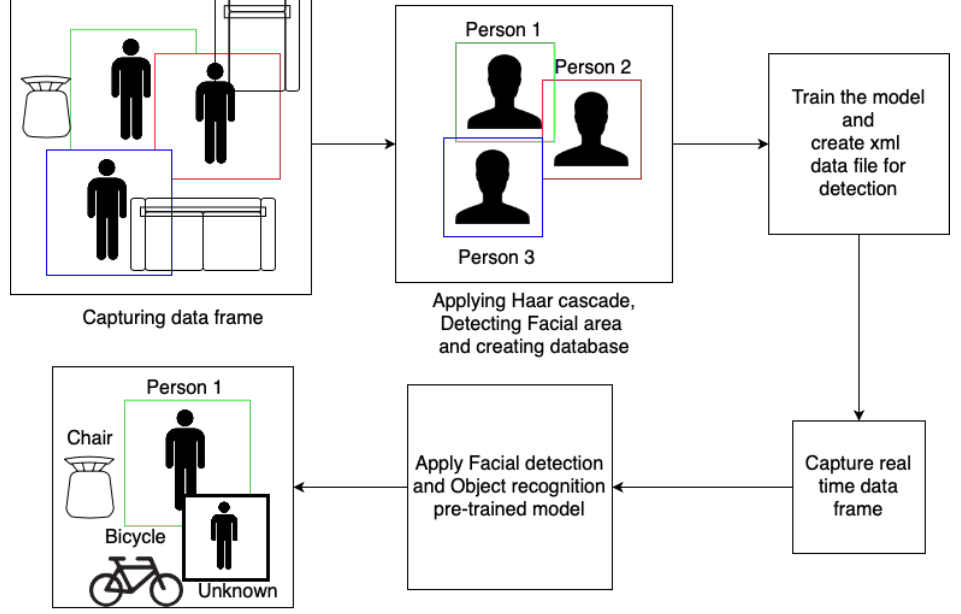
Figure 5. Face and object